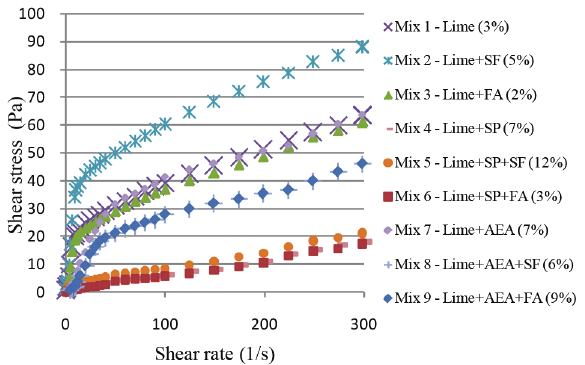
Fig. 1. Shear stress versus shear rate for different grout mixes Values in brackets give the CV